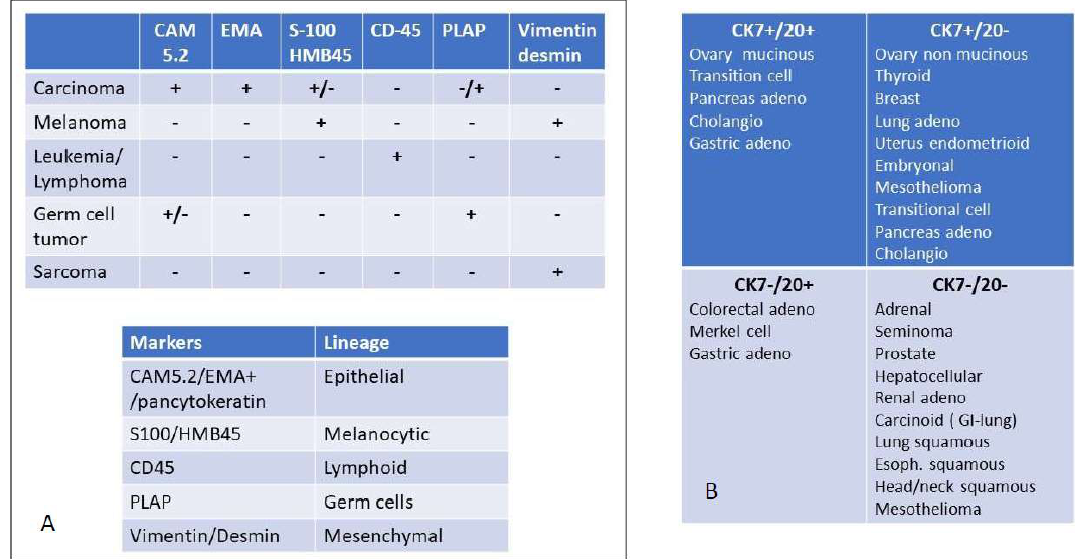
Figure 2. Immunohistochemical evaluation to detect the major origin of metastatic lesions: Panel ( A ) key screening antibody panel to detect the lineage of origin. It should be noted that melanoma is positive for vimentin but not for desmin, except for rare cases such as osteogenic melanoma which might express desmin [22] and sinovial mucosal melanoma [23]. In sarcoma desmin is not always expressed. For instance, solitary fibrous tumors and hemangioperycitoma like tumors are generally negative for desmin, as well as epitheliod sarcomas [24]. EMA = Epithelial Membrane Antigen, PLAP = Placenta Alkaline Phosphatase, Panel ( B ) once the diagnosis of carcinoma is reached, the cytokeratin expression may be useful to further delineate the tissue or organ of origin. The differential expression of CK 7 and CK 20 is among the most relevant discriminants of carcinomas of epithelial origin.